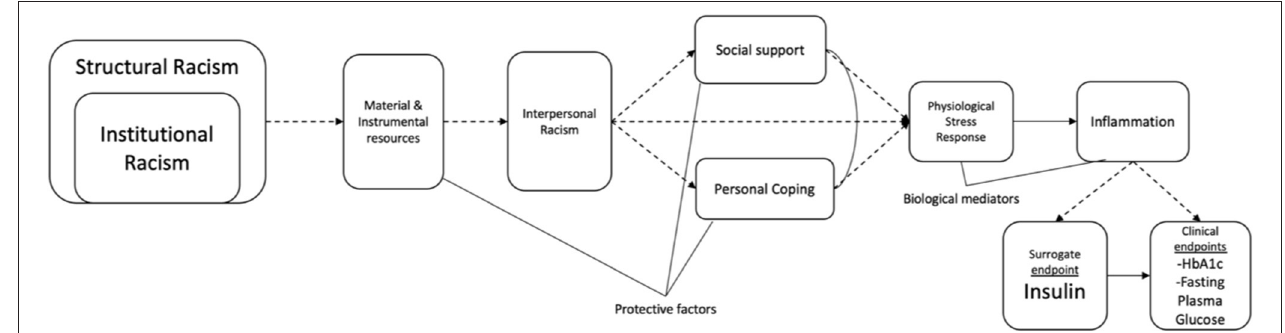
FIGURE 2 | Biobehavioral research examining the racism in relation to clinical surrogates and endpoints of Type 2 diabetes mellitus. This figure presents an example of how to examine the biobehavioral response to racism among Latinx persons and its impact on the development of prediabetes and T2DM. Solid arrows represent established associations and dashed arrows represent potential pathways. Curved lines represent correlations. Solid lines are merely descriptive. For example, insulin has a solid arrow to the clinical endpoints, hemoglobin Alc (HbAlc) and fasting plasma glucose (FPG), since it is established that insulin is the key hormone responsible for bringing glucose into cells and controlling the amount of glucose in the blood. Prediabetes is diagnosed with a HbAlc between 5.7 and 6.4% and a FPG of 100–125 mg/dL. T2DM is diagnosed with a HbA1c > 6.5% and a FPG > 126 mg/dL. Plasma insulin is usually monitored together with HbA1c and FPG to discern insulin resistance and distinguish between TlDM and T2DM. Both structural and institutional racism shape the economic, educational, legal, environmental, and cultural conditions in which Latinx communities are embedded. In turn, this shapes the food environments, health care access, and living conditions that allow Latinx persons to engage in health behaviors and preventive measures. Nevertheless, material and instrumental resources available to Latinx persons, families, and communities may offset the challenges present in a racist society (16, 46). Structural and institutional racism also produce the conditions and settings in which Latinx people experience interpersonal racism. Social support and personal coping can mediate or moderate the effects of interpersonal racism on physiological stress responses in both the ANS and HPAA stress systems. Here, they are displayed as mediators, assuming that this model is using longitudinal data and the temporality precedence is met ( 136). If assumptions are not met for a mediation analysis, protective factors against interpersonal racism have been examined as moderators [see (137)]. Acute and chronic racial stress activate immune and inflammatory responses related to β -cell production, pro-inflammatory cytokines (e.g., tumor necrosis factor- α , IL-6, IL-8), and abdominal adiposity. The biopsychosocial pathway was adapted from Hackett and Steptoe (118), Joseph and Golden (138), and Tsenkova et al.